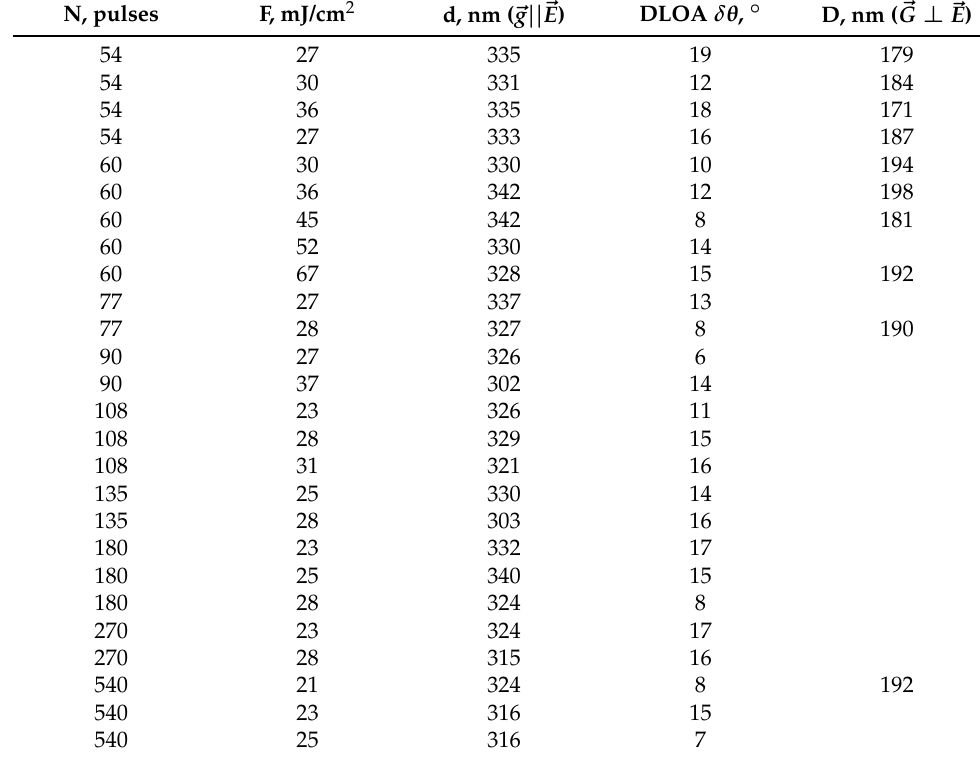
Table A1. Statistical data of the period end DLOA of the obtained gratings depending on number of pulses N and Laser fluence